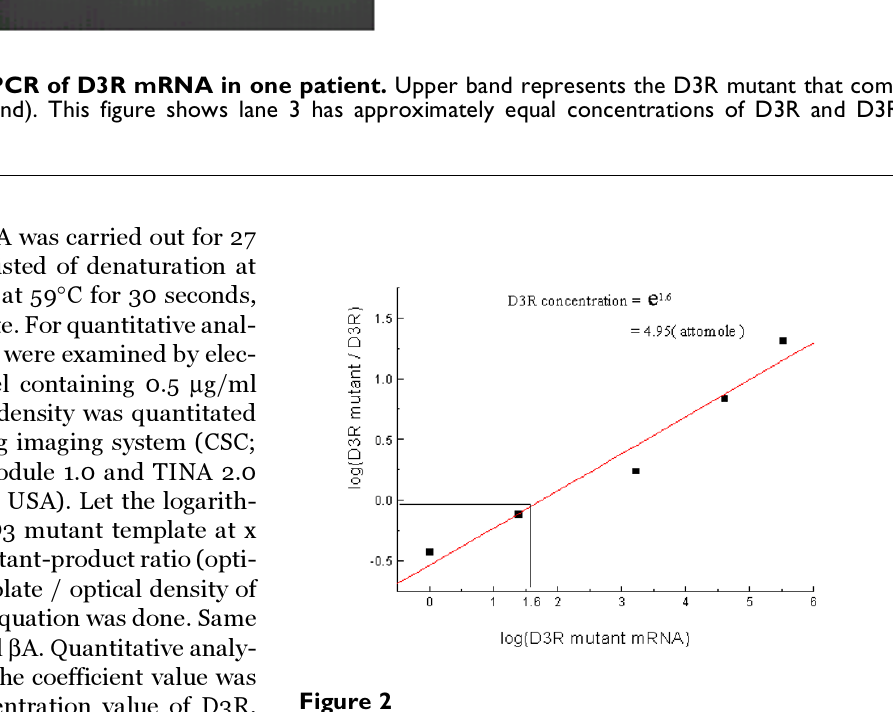
Figure 2 Analysis of actual D3R mRNA concentraion of Figure 1. The exact concentrations of the patient in Figure 1a. were shown. The 0 point on the Y axis represents equal concen- trations of D3R and D3R mutant, and the corresponding point on the X axis represents the actual value of D3R (loga- rithmic